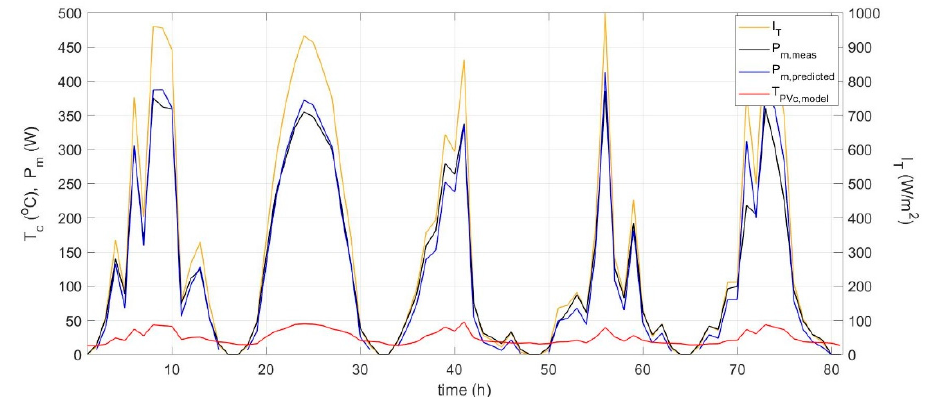
Figure 13. Predicted vs. measured power output for the fixed PV generator during the 5 consecutive days of Figure 12.